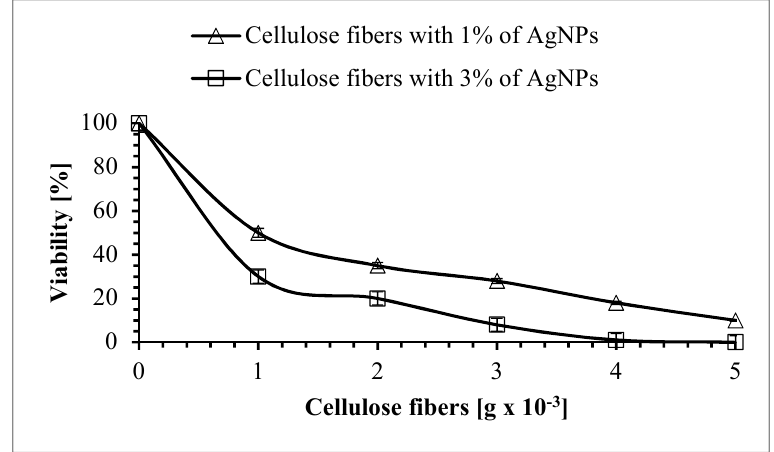
Figure 16 . The effect of cellulose fibers modified with AgNPs on the viability of Escherichia coli .